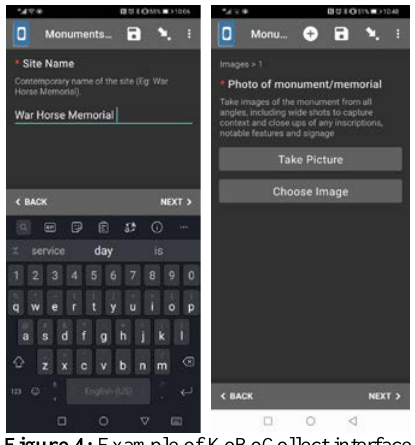
Figure 4: Example of KoBoCollect